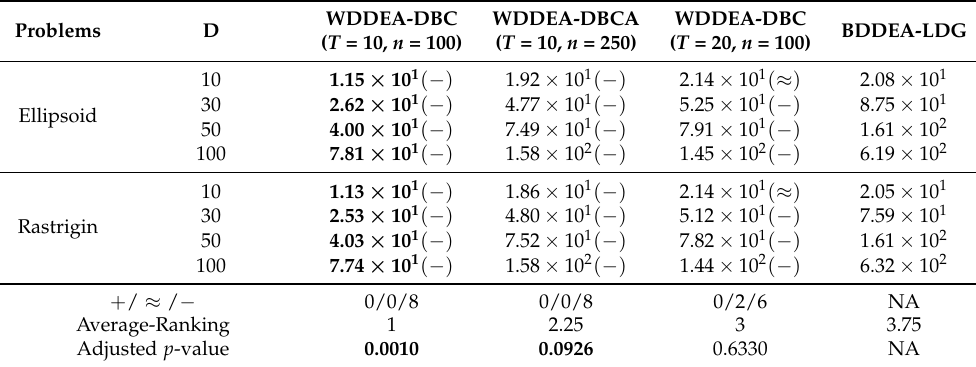
Table 2. The average of time cost (unit: second) over 25 independent runs of different offline algorithms on Ellipsoid and Rastrigin problems (the best results and the lowest p -values are shown in bold).